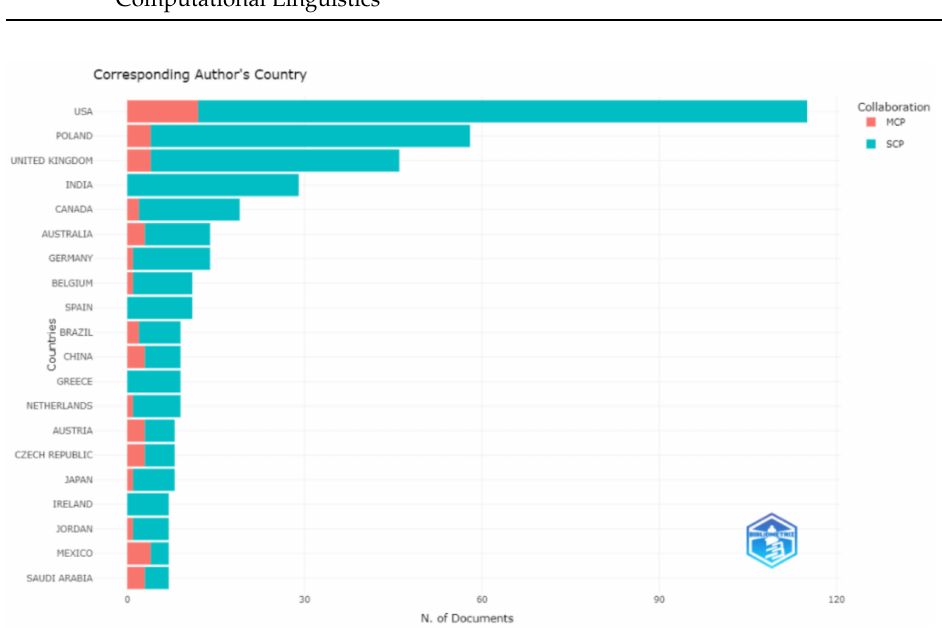
Figure 4. Corresponding author’s country (this chart was generated by Biblioshiny). SCP = Single Country Publications, MCP = Multi Country